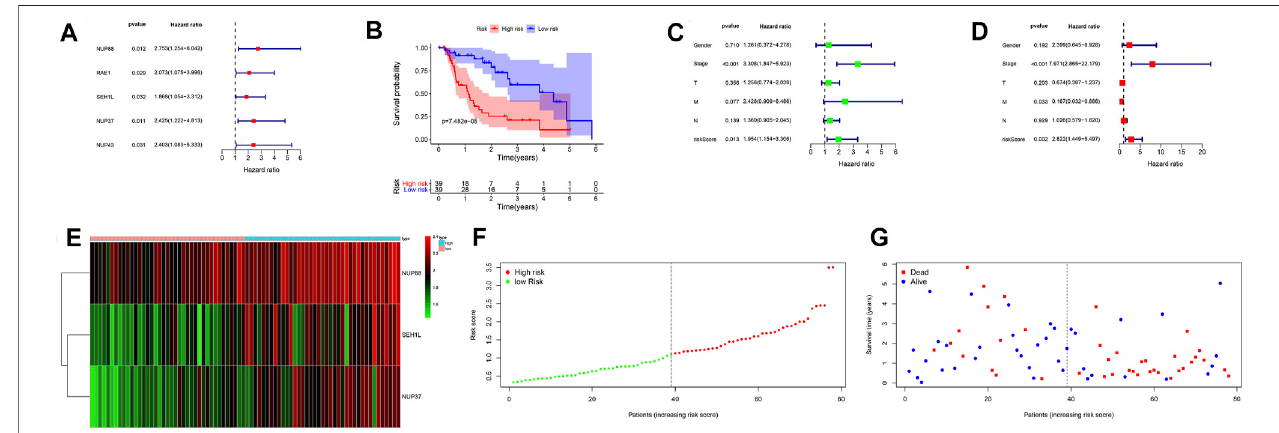
FIGURE4 | Prognostic signatures ofOS in EAC patients. (A) Forest plot ofunivariate Cox regression analysisbased on IGs. (B) K-M survival plot ofhigh- and low- risk score patients. (C) Forest plot of univariate Cox regression analysis based on the clinical information and risk score. (D) Forest plot of multivariate Cox regression analysis based on the clinical information and risk score. (E) Heatmap of NUP88, NUP37, and SEH1L in EAC patients. Green represents low gene expression, and red represents high expression. (F) Risk score curve of high- and low-risk score patients. The dotted line represents every individual, and patients are categorized into low-risk and high-risk groups at the in fl ection point. (G) Survival status and time distributed by the risk score. The red dot represents the dead, and blue represents the living. With an increase in time, more and more patients died. T: tumor; M: metastasis; N: lymph node.